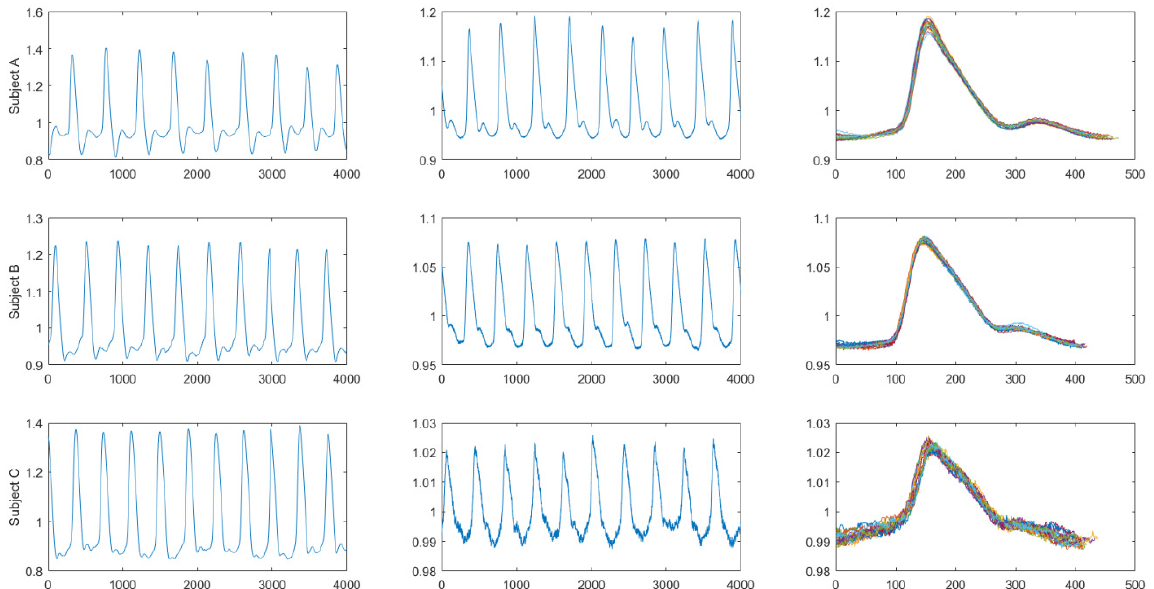
Figure 3. Variation in digital volume pulse from Subject A (healthy elderly subject), Subject B (healthy elderly subject), and Subject C (patient with type 2 diabetes). Left column: single left radial pulse from each subject. Middle column: single left index finger digital volume pulse from each subject. Right column: A total of 20-cycle overlapping index finger digital volume pulses from each subject, showing the widest variation in waveforms in Subject C. Table 2. Three coefficients (C 0 , C 1 , and C 2 ) of discrete-time Fourier series from Subjects A and B